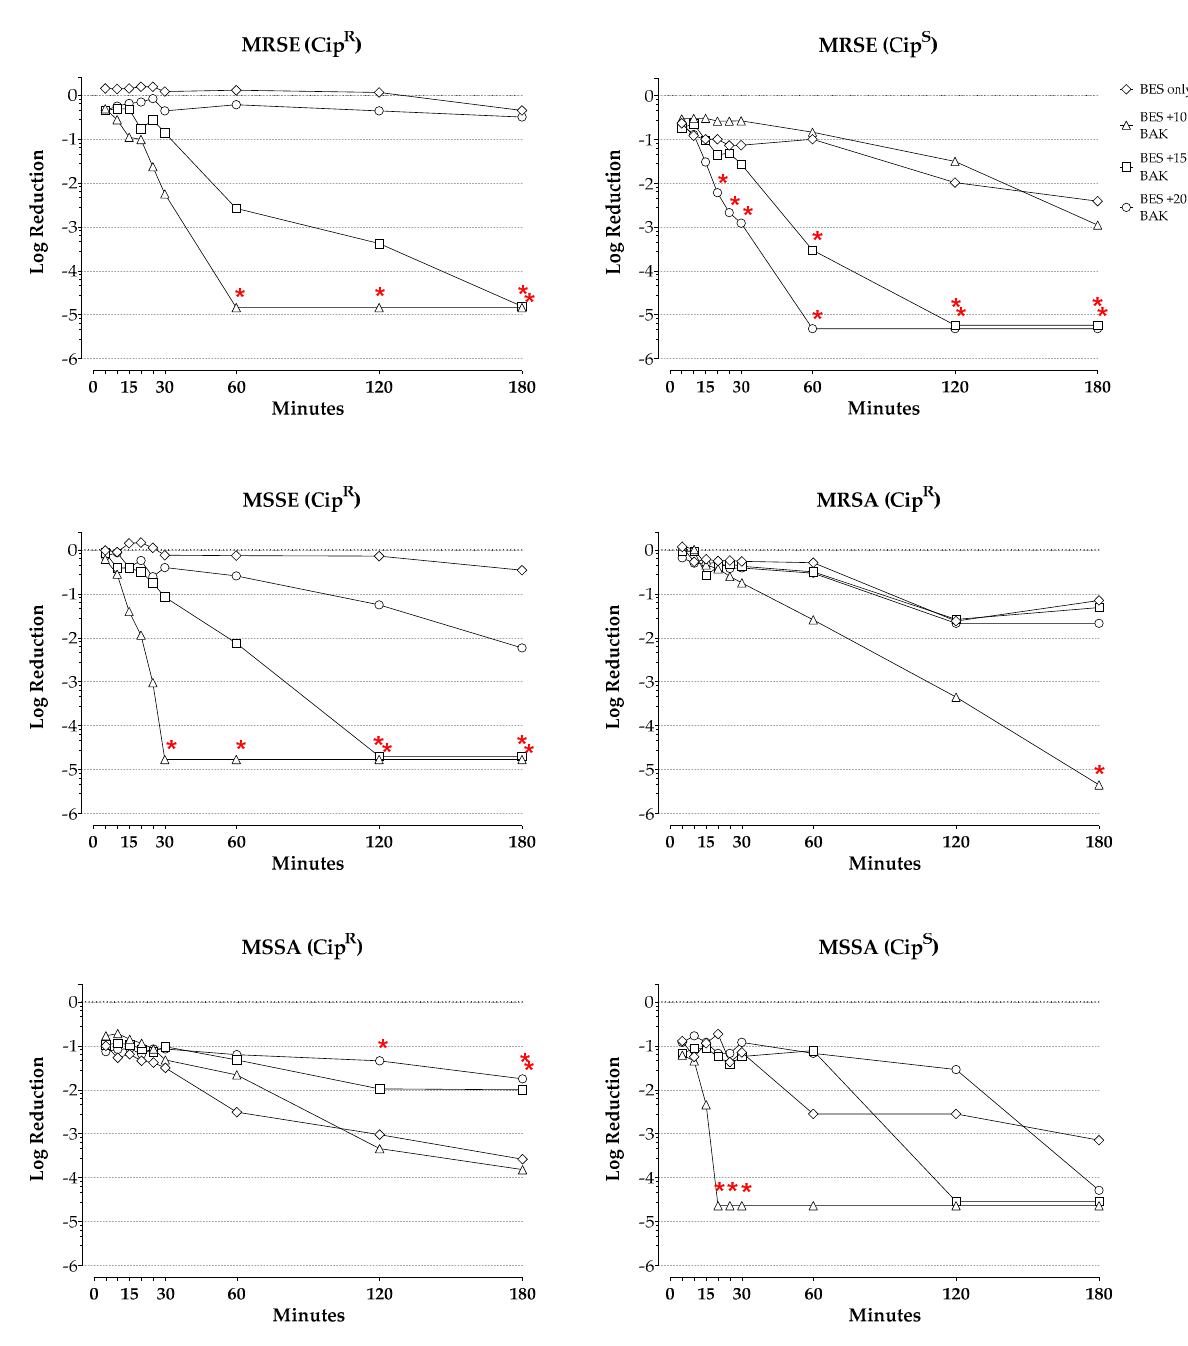
Figure 3. Log reductions in viable organisms over time with 100 µ g/mL besifloxacin alone or combined with increasing amounts of BAK for S. epidermidis and S. aureus isolates by resistance profile. Starting (0 min) viable cell densities for each isolate were ~10 5 CFU/mL. All of the plots represent one tested isolate, with the exception of MRSE (Cip S ), which represents the average of two tested isolates. * p < 0.05 compared with besifloxacin. BES = besifloxacin, BAK = benzalkonium chloride, MRSE = methicillin-resistant S. epidermidis , MSSE = methicillin-sensitive S. epidermidis , MRSA = methicillin-resistant S. aureus , MSSA = methicillin-sensitive S. aureus , Cip R = ciprofloxacin-resistant, Cip S =